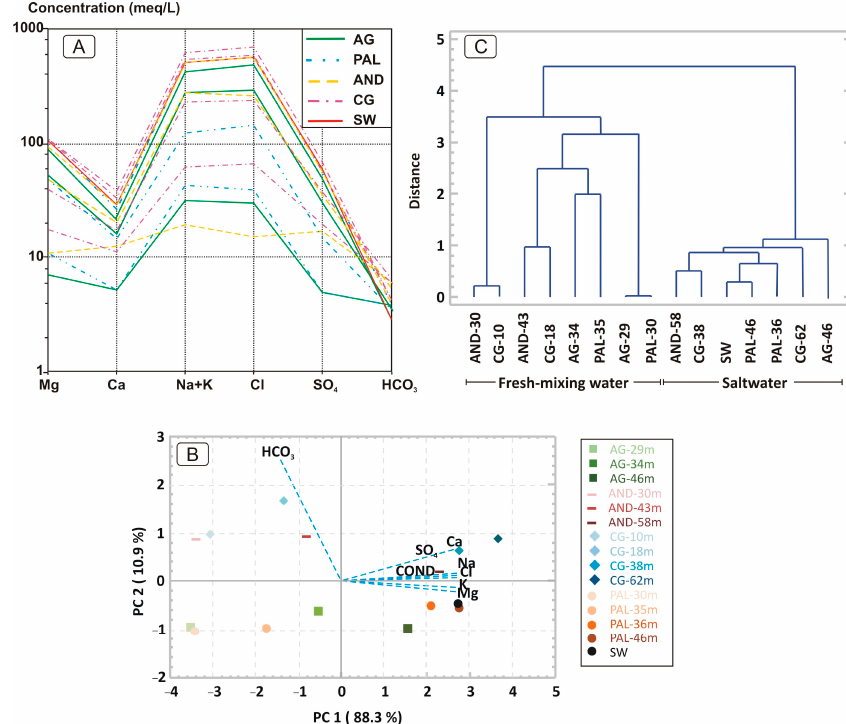
Figure 2. ( A ): Schöeller-Berkalo ff diagram showing groundwater and seawater concentrations. ( B ): Principal component analysis of physico-chemical variables and observations. ( C ): Dendrogram of cluster analysis between observations corresponding to samples taken at di ff erent depths in the aquifers.